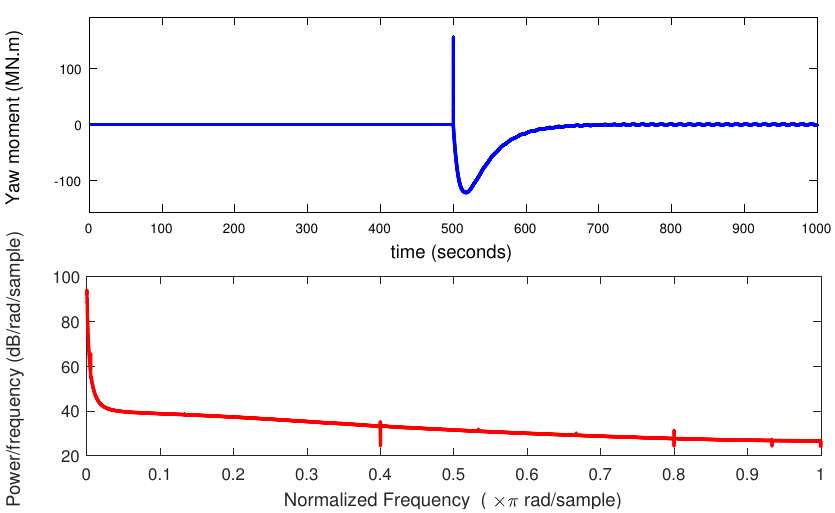
Figure 9. Yaw bearing moment and its power spectral density.